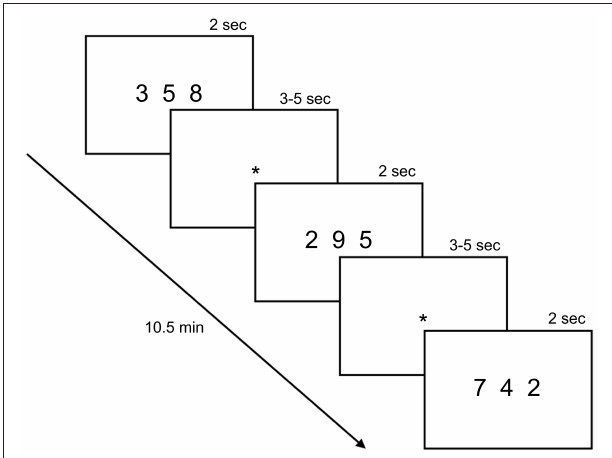
FIGURE 2 | fMRI task. The paradigm consisted of alternating blocks of the experimental and control condition. In the experimental condition, subjects had to decide if the three presented numbers were in ascending or descending order (numerical order task). For instance, subjects had to press “yes” in the first and last trial shown in the picture and “no” for the second one. In the control condition, subjects had to indicate if the number 2 was present. Every stimulus was presented for 2s, followed by a screen with a fixation cross (*) shown for 3–5s. Reprinted from Kucian et al. (2011a), copyright (2011) with permission from